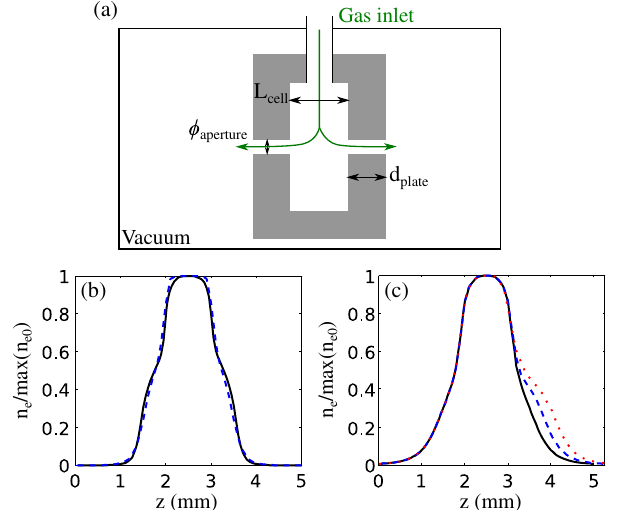
FIG. 1. (a) Schematic side view of gas cell. Normalized density profiles (b) obtained using simulations with full 3D geometry (black solid line) and reduced geometry (blue dashed line) for L ¼ 1 mm and for plate of 200 μ m aperture diameter and cell 500 μ mthickness.(c)obtainedwithreducedgeometryand 600 μ m aperture diameter, 500 μ m thick entry plate and 500 μ m (black solidline) 750 μ m (bluedashedline) and 1000 μ m (reddottedline) thick exit